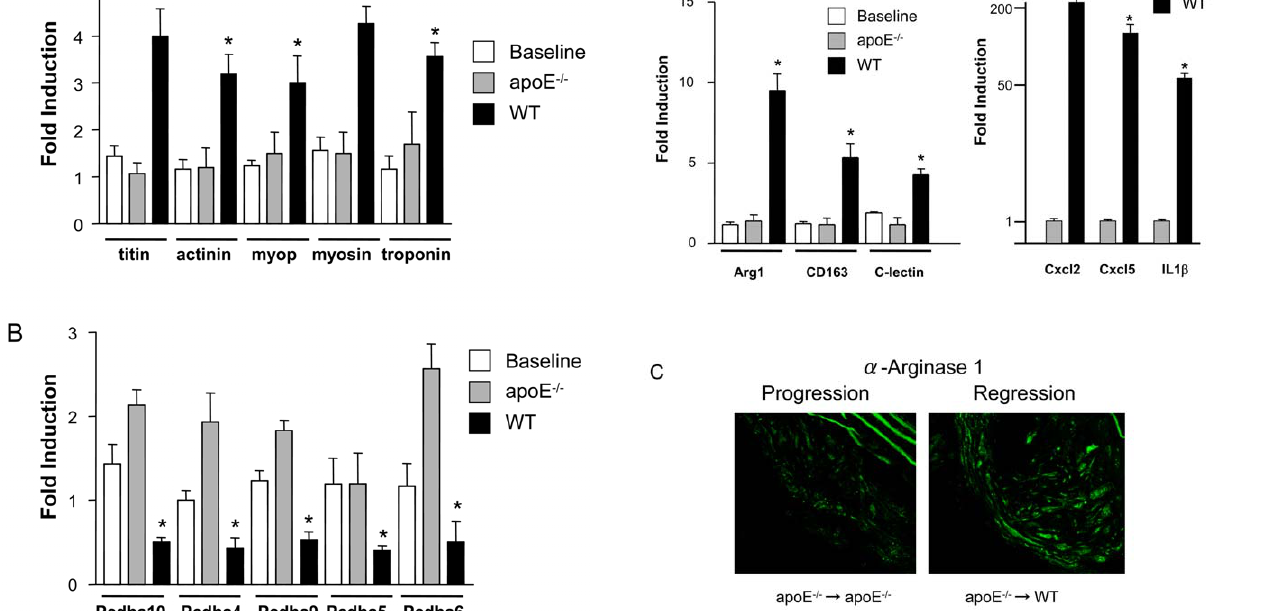
Figure 3. Regression is characterized by increasing expression of contractile proteins and down-regulation of cadherins. CD68 + cells were selected from plaques by LCM, RNA was isolated and qPCR performed in order to validate microarray results. The results of qPCR showed that the contractile proteins were up-regulated (A), whereas members of the cadherin family were down-regulated (B). The symbol * corresponds to statistical significance, p , 0.05, when mRNA level in the aortas from a transplanted group (apoE 2 / 2 , WT) was compared to mRNA in aortas from donor apoE 2 / 2 mice (Baseline). 9 mice were analyzed per group. Cyclophilin A was used for normaliza- tion in both cases.